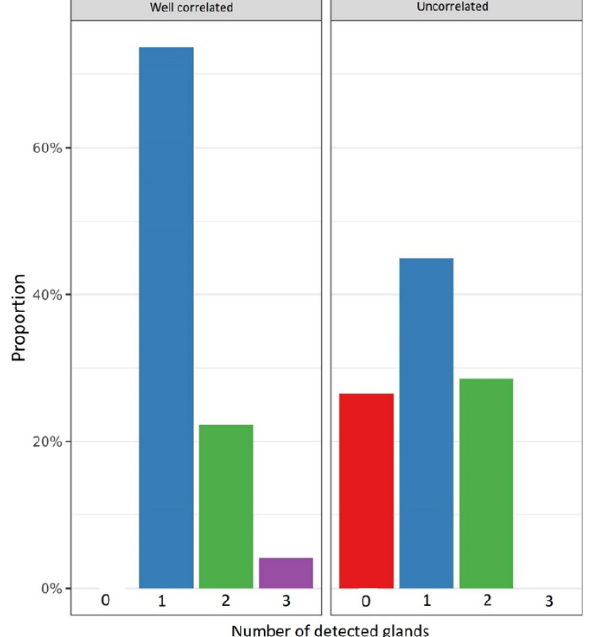
Figure 6. Number of glands detected by 18 F-choline positron emission tomography/contrast-enhanced computed tomography in the well-correlated group ( n = 220) and uncorrelated group ( n = 49).